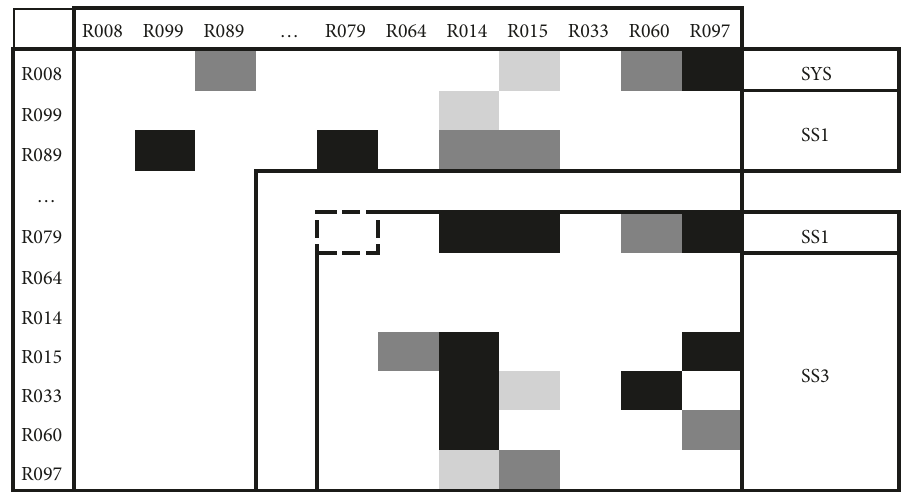
Figure 6: Illustration of the SS 3 -centered cluster C 2 and its interdependencies with transverse